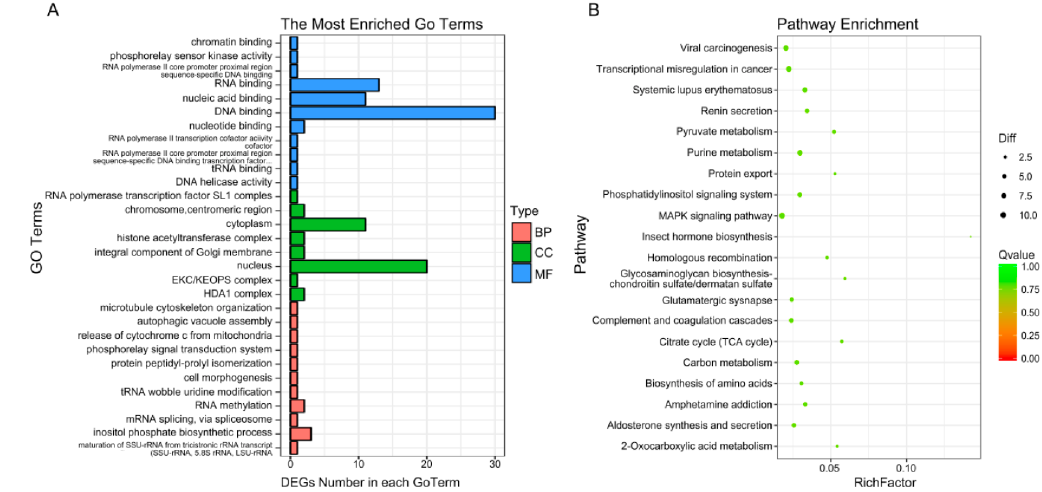
Figure 5. GO and pathway analysis of di ff erentially expressed genes. ( A ) Enriched 30 GO analysis of DEGs. GO analysis covered the three domains biological process, cellular component and molecular function. ( B ) KEGG enrichment analysis of DEGs. The enrichment 30 pathways were